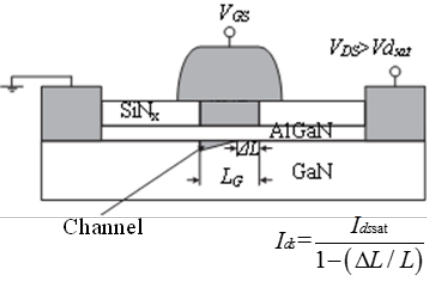
Figure 4. The schematic diagram of the short channel modulation effect.